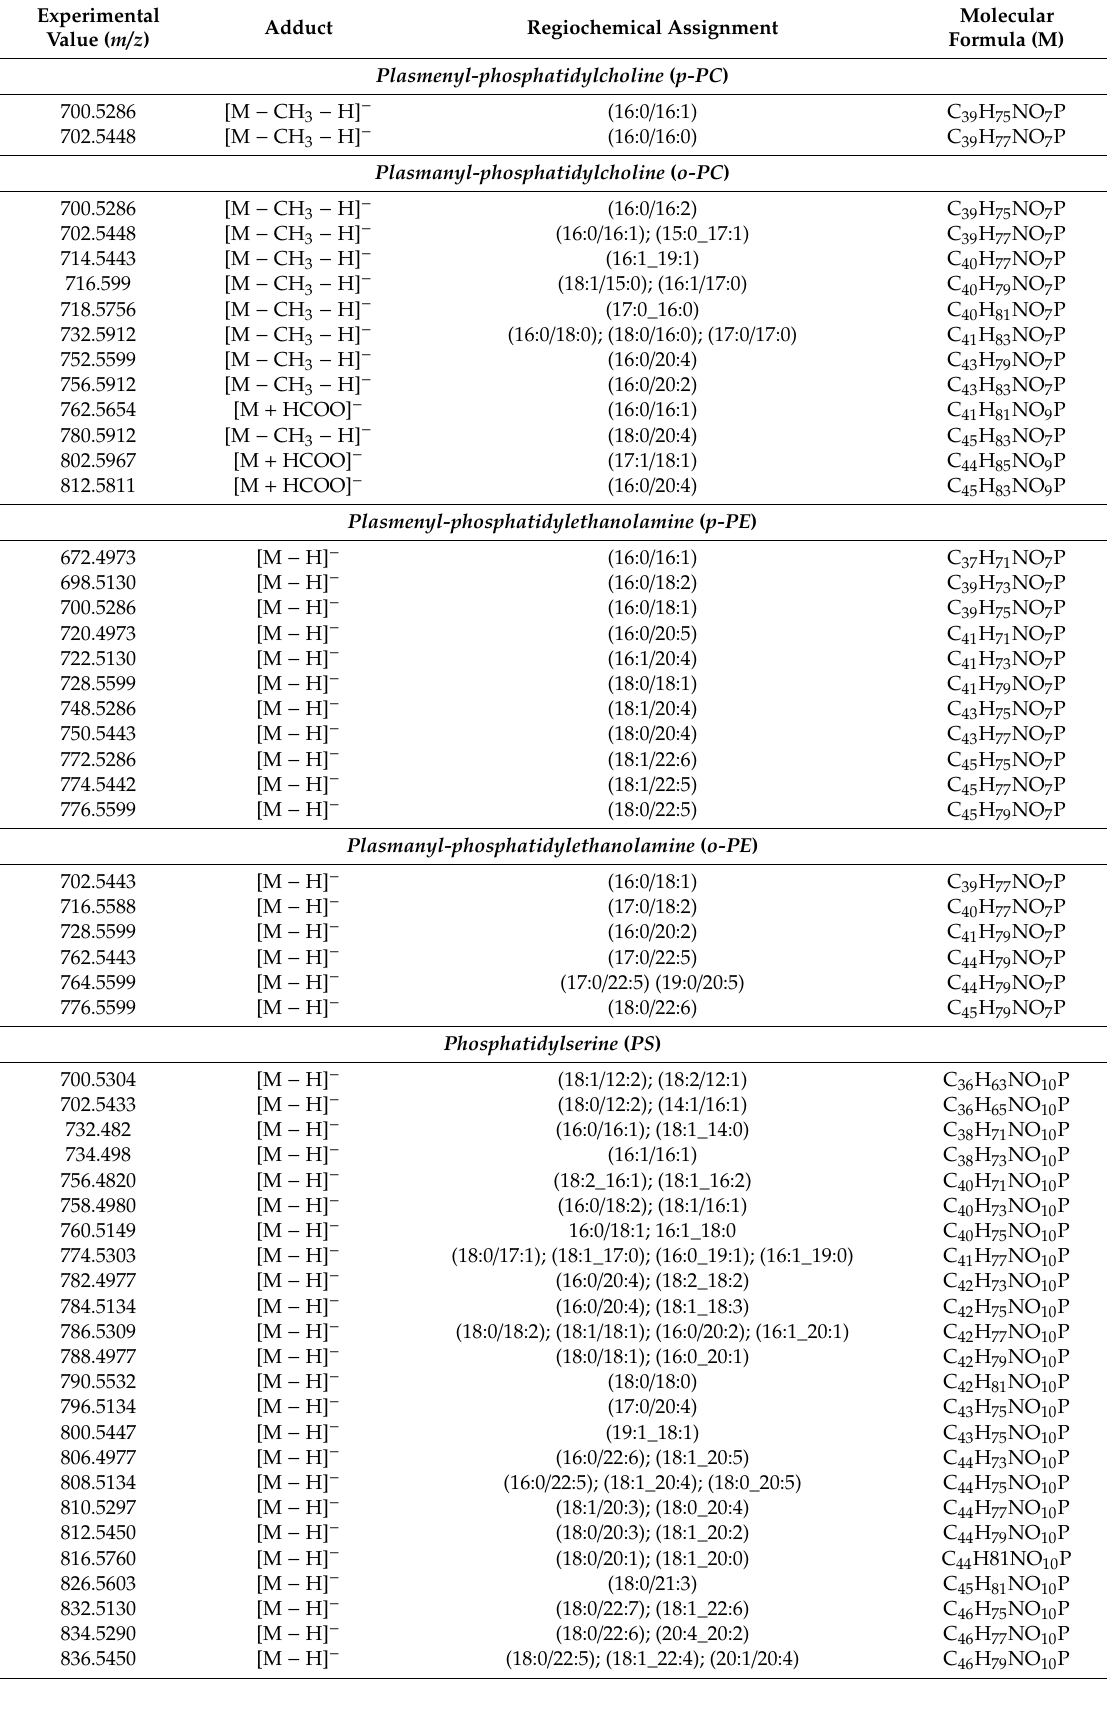
Table 1. Minor phospholipids identified in human dermal fibroblasts by liquid chromatography electrospray ionisation tandem mass spectrometry (LC-ESI( − ) MS / MS) and mass spectrometry (MS) 3 . Experimental Value ( m / z